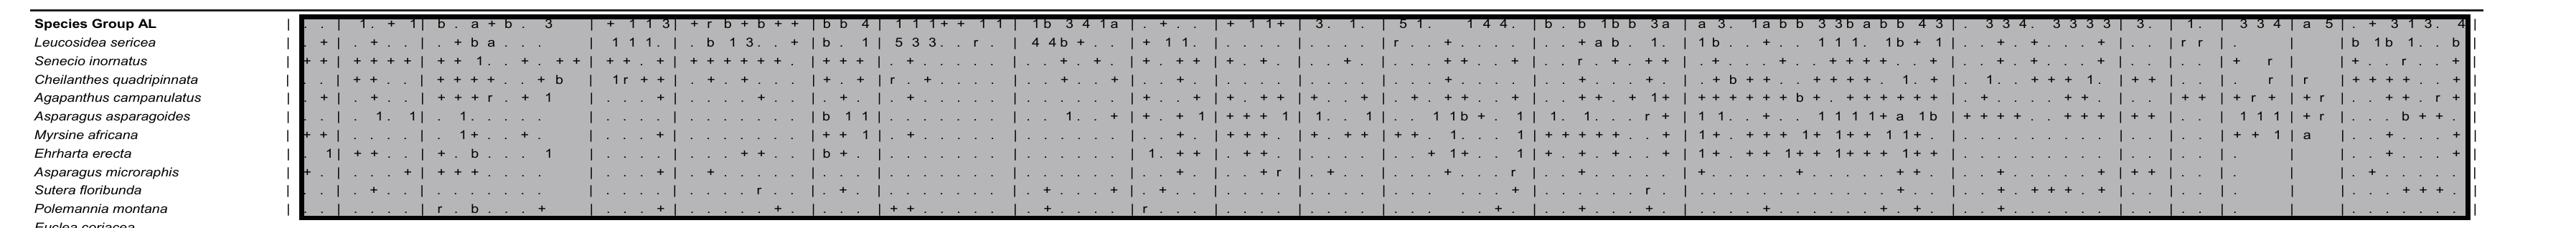
TABLE 1 (Continues.....) Phytosociological table for the shrubland communities of